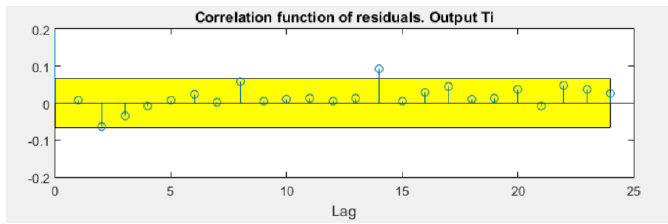
Figure 8. Residual autocorrelation — Experiment C — order 2.